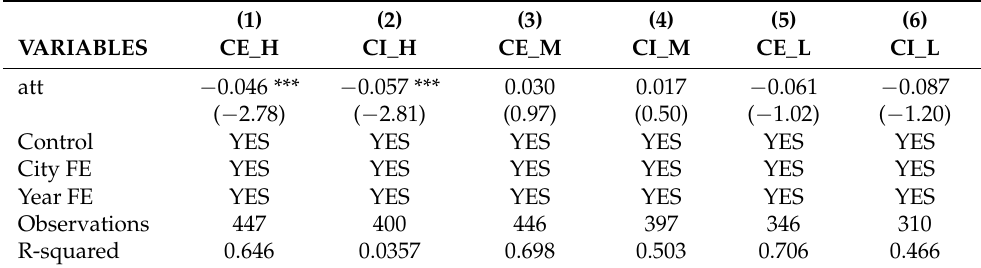
Table 13. Heterogeneity of income level structure